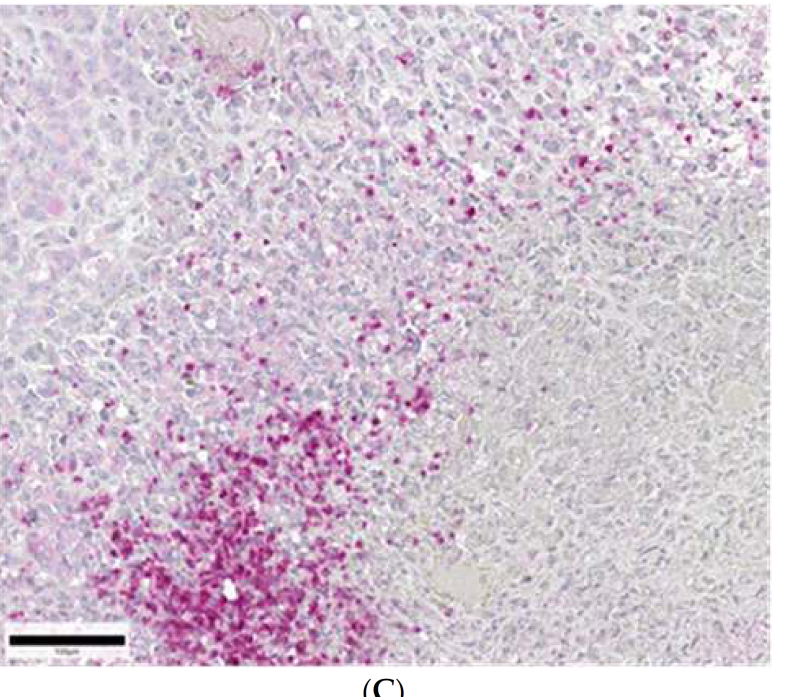
Figure 2. ( A ): Breast cancer (MCF7 105-1A-01). BSA-1 lectin histochemistry in xenograft breast cancer. Tumor-infiltrating dendritic cells were characterized thanks to their high BSA-1 binding capacity. BSA-1 binding cells are considerably detected in all surrounding tissues and moderately in the epithelial tumor tissue itself. ( B ): Neuroblastoma (IMR32 208-6A-06). Tumor-infiltrating